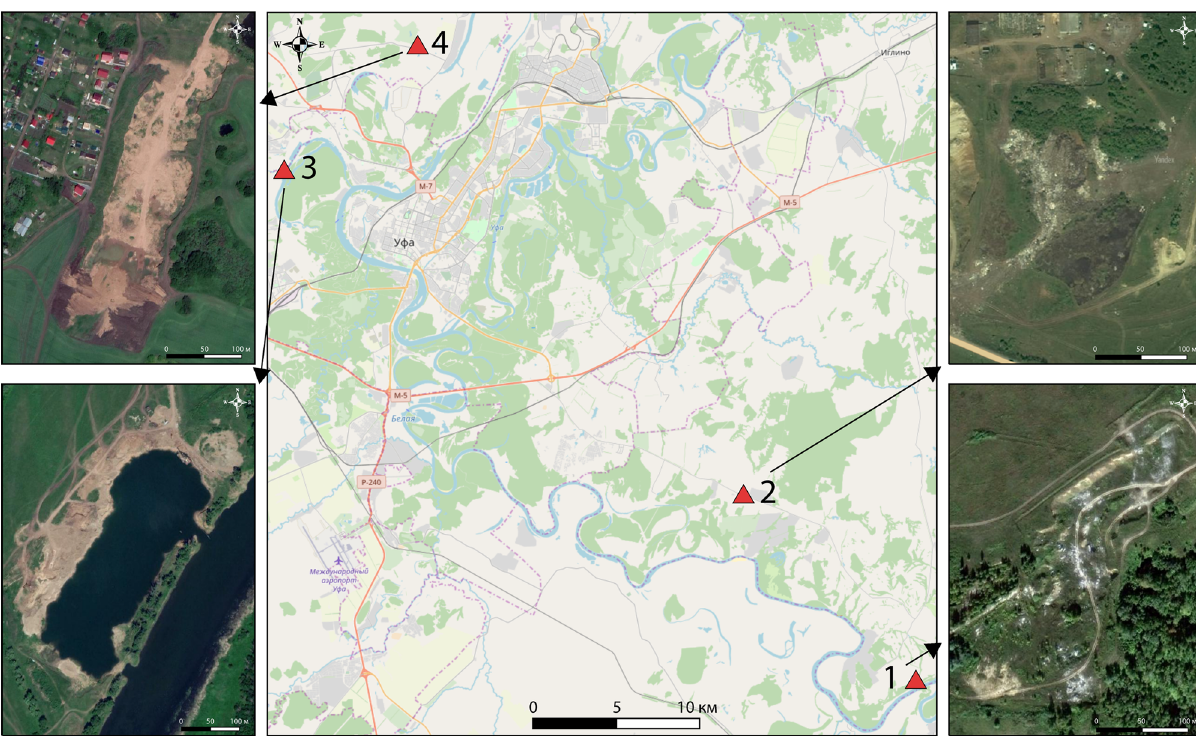
Figure 1: Location of research objects ( No. 1 – 4 – sequential numbers of the studied quarries )